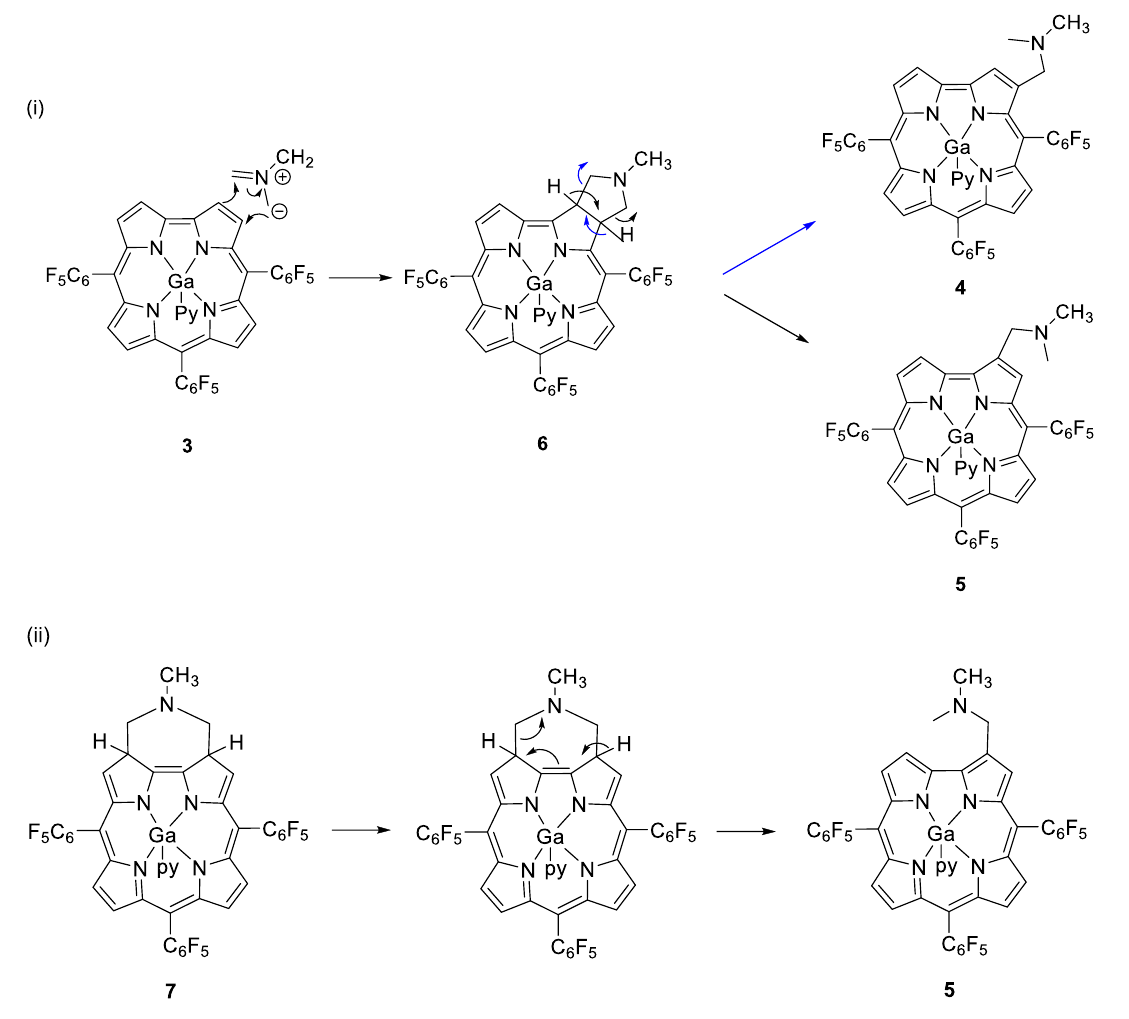
Scheme 2. Possible pathway for the formation of compounds 4 (blue arrows) and 5 (black arrows), via thermal ring opening of cycloadducts 6 or 7 .